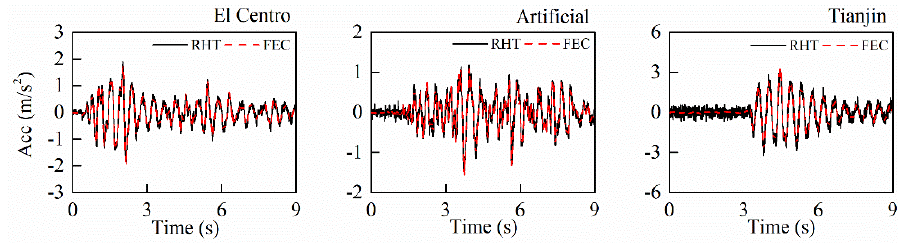
Figure 9. Comparison of acceleration response of the structure’s top floor